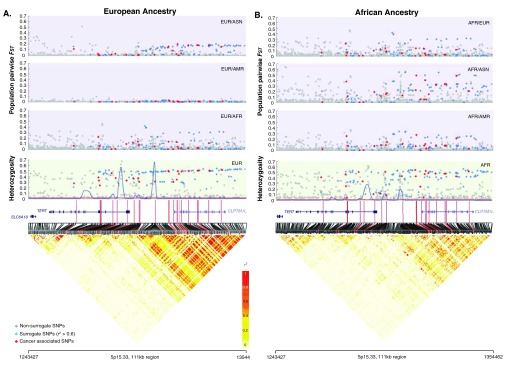
Summary of population genetics parameters in European (
A.) and African (
B.) ancestry individuals for 5p15.33. Linkage disequilibrium (LD), recombination hotspots, heterozygosity, and pairwise
F
st values are shown for the cancer-associated SNPs (red dots), surrogate SNPs (blue dots), and non-surrogate SNPs (grey dots). LD pattern (see color legend) is shown for SNPs with a MAF ≥0.05. The red lines represent an extension of the location of the cancer-associated SNPs. The blue lines in the heterozygosity plot indicate the location of the recombination hotspots. For the pairwise
F
st estimates, the populations are indicated in the top corner of each graph. AFR = African ancestry; EUR = European ancestry; AM = American ancestry; ASN = East Asian ancestry.